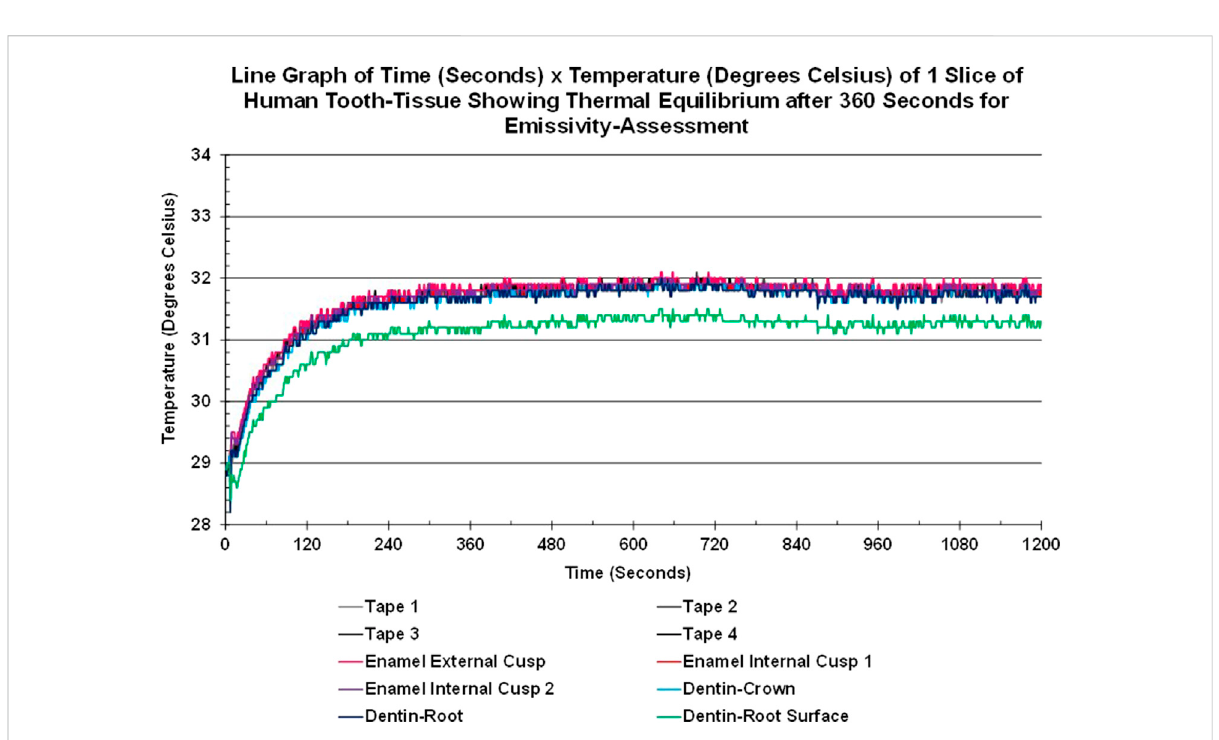
FIGURE 4 LinegraphshowingtheTime-TemperatureCurvesofareas-of-interest ofenamel,crown-dentin,root-dentin, root-surface-dentinofasliceof human tooth-tissue and tape areas-of-interest achieving thermal equilibrium within the cube after approximately 6 min and remaining stable over the next 14